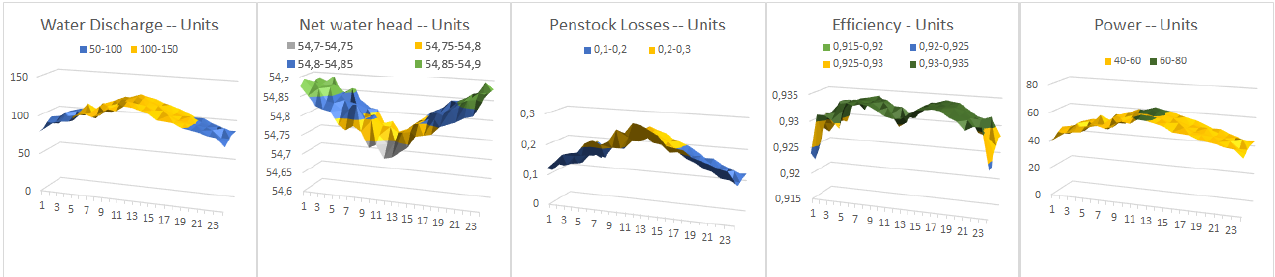
Figure 16. CRO-SL with DE(rand/1/bin) and Gaussian Mutation substrates— CRO ( 2 r ,4 ) . Results of Water discharge (m 3 /s). Net water head (m). Penstock (m). Efficiency (%) and Power generated (MW/h). Daily dispatch (24 h).